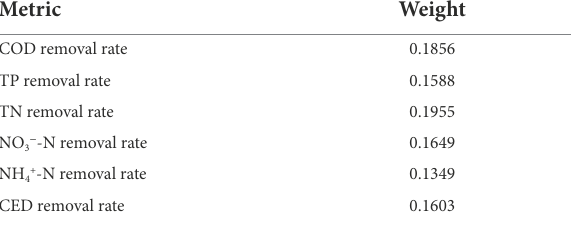
TABLE 3 Final weight of each